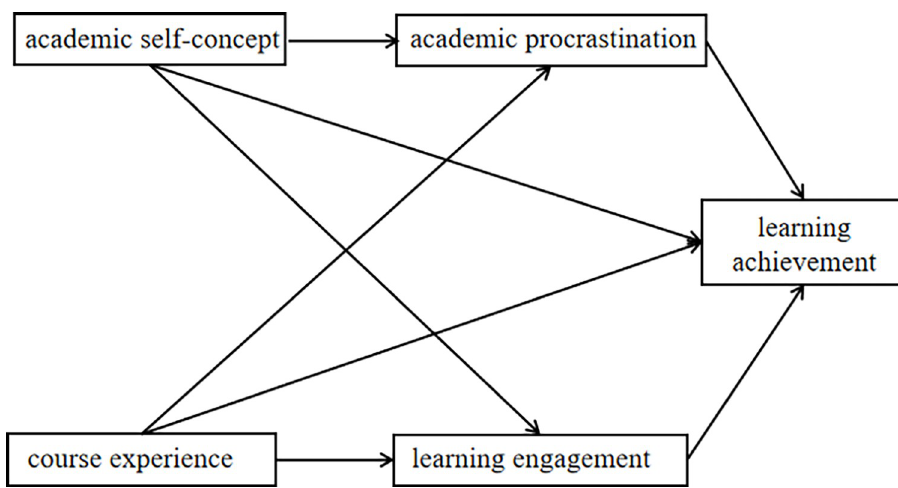
Fig 1. Mediation model of university students’ EFL learning process within blended teaching model